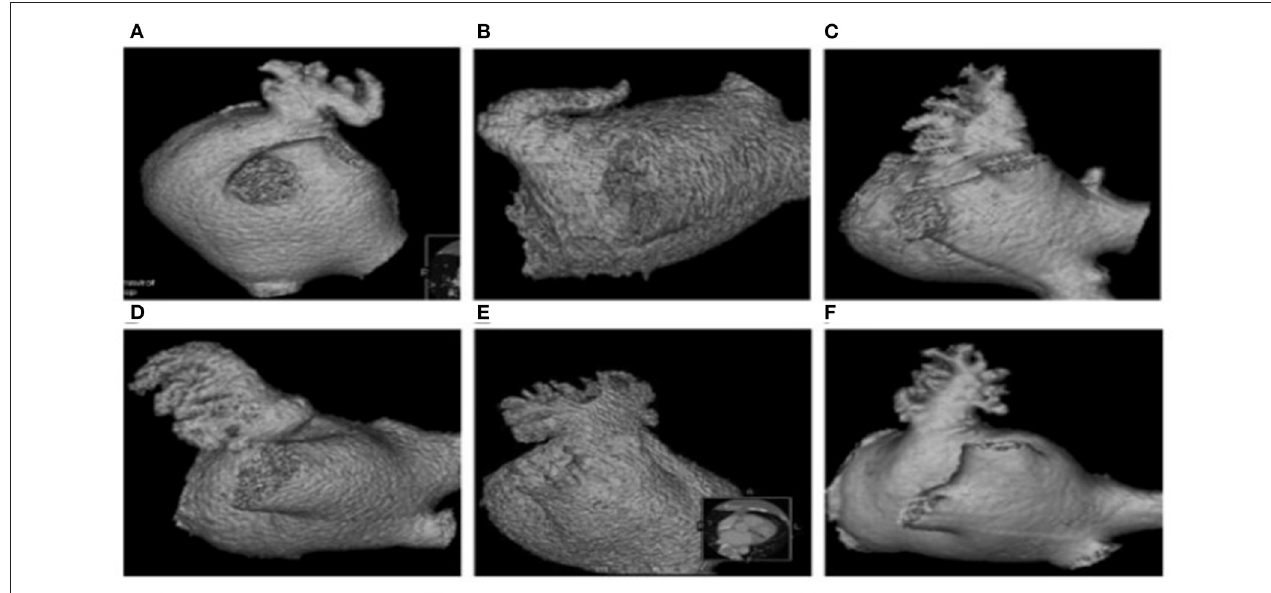
FIGURE 2 | Morphological types of LAA. Chicken Wing (A,B) , Windsock (C,D) , cauliflower (E) , and cactus (F)